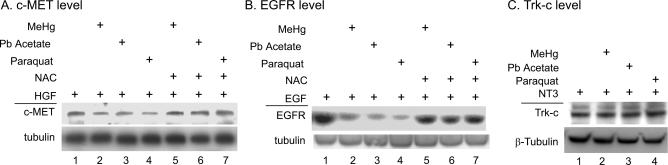
Exposure to MeHg, Pb, and Paraquat Caused Reductions in Levels of c-Cbl Targets c-Me and EGFR, but Not of TrkCCells were analyzed as for Figure 5, but with antibodies against c-Met and EGFR. The results for the c-Cbl Targets c-Met (A), EGFR (B), and TrkC (C) are shown. All experiments were repeated at least three times.